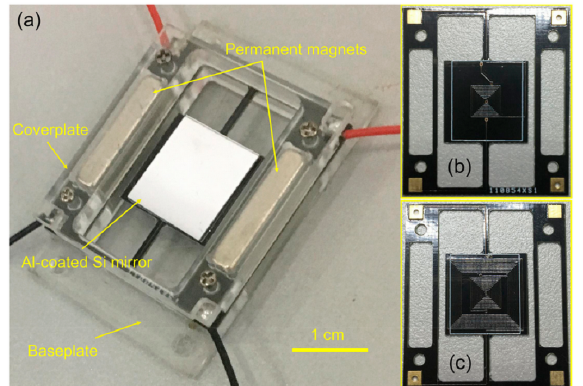
Figure 11. ( a ) Prototype of the electromagnetic scanning micromirror with a plexiglass package; ( b ) front-side view of the platform integrated with copper coils for sensing; ( c ) back-side view of the platform integrated with copper coils for sensing and driving (reprinted from [126], copyright (2018), Creative Commons